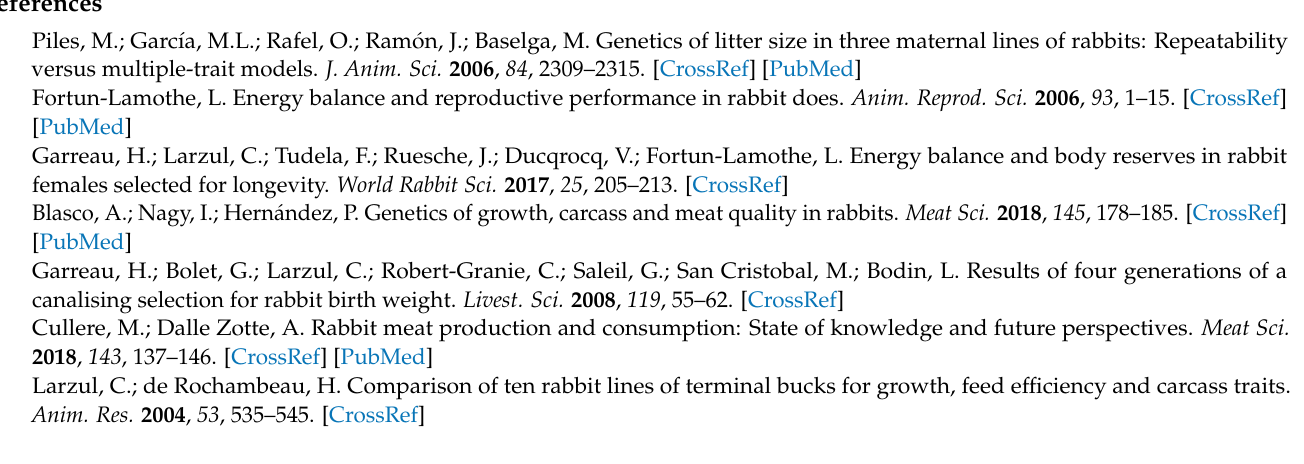
Table S3: Complete fatty acid profile (% of total FAME) of the fore legs of Lean and Fat rabbits in third and fourth generations of 15 divergent selection for total body fat content., Table S4: Complete fatty acid profile (% of total FAME) of the abdominal wall of Lean and Fat rabbits in third and fourth generations of divergent selection for total body fat